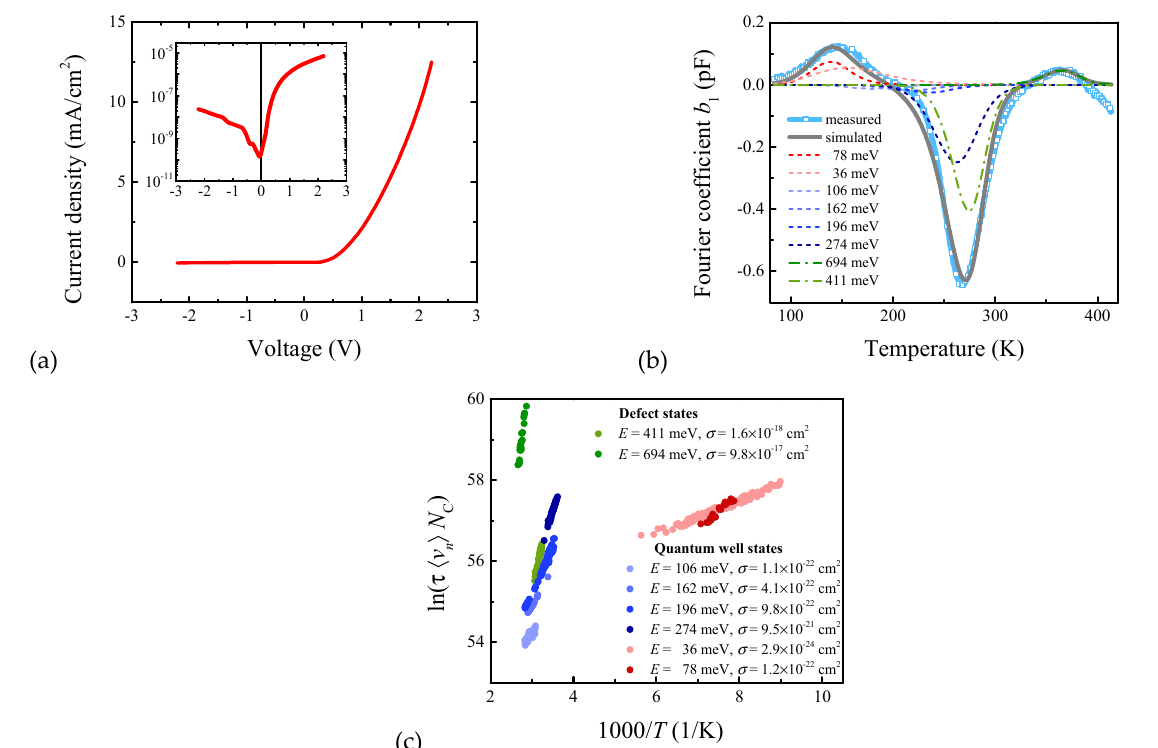
Figure 2. ( a ) Steady-state current-voltage characteristic of heterostructure with x = 0.32%, y = 13.3%, and d = 16.6 nm. ( b ) The spectrum of the Fourier coefficient b 1 together with simulations of various energy states. ( c ) The Arrhenius plot.